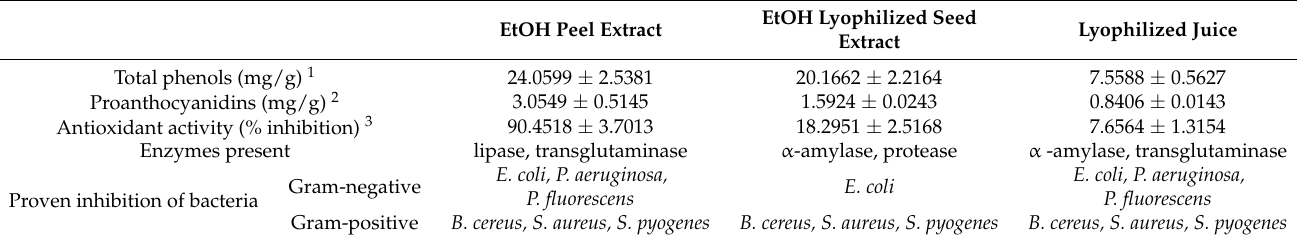
Table 6. The most promising P. granatum samples for further